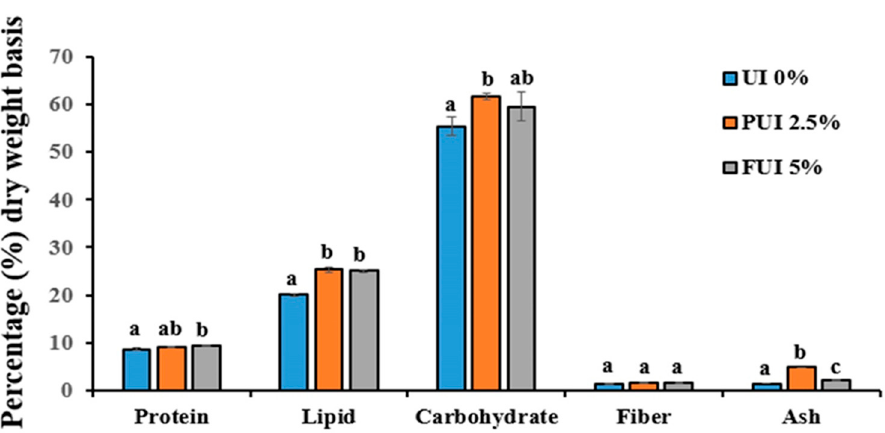
Figure 4. Nutritional composition of cookies prepared with UI 0%, PUI 2.5%, and FUI 5% UI. Data represent the mean ± SE of 3 observations, where groups not sharing a letter are expressed as significantly different ( p < 0.05).